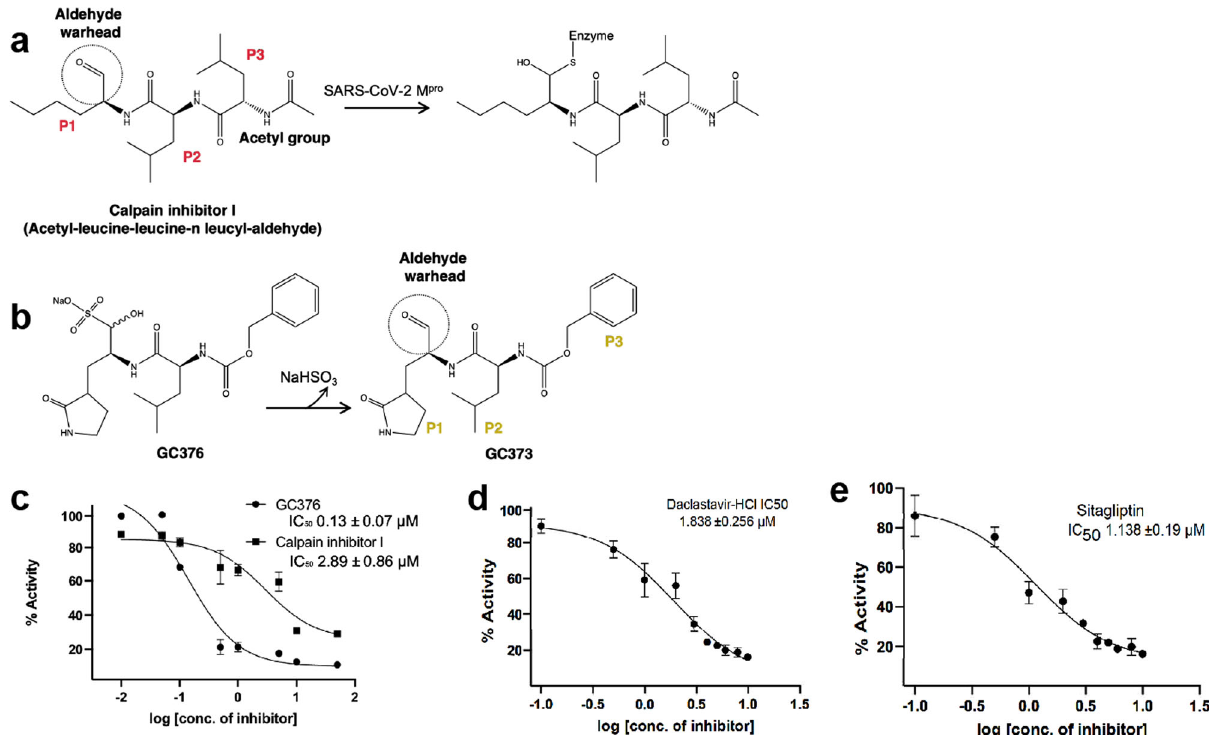
Fig. 8 Inhibitions of the Mpro and PLpro activities in vitro by screened compounds. a Schematic representation of the inhibition of Mpro by MG-101. Chemical groups and substrate positions (P1 – P3) are indicated. b Chemical structures of GC376 (prodrug) and GC373 (active drug). c IC 50 values of MG- 101 and GC376 for the cleavage of (Dabcyl)-KTSAVLQ*SGFRKME(Edans) substrate by Mpro. A cleavage site is indicated by an asterisk. The inhibitory activities of d Daclastavir-HCl and e Sitagliptin against PLpro were tested using fl uorogenic peptide Z-RLRGG-AMC as the substrate. N = 3, values are represented as mean ±